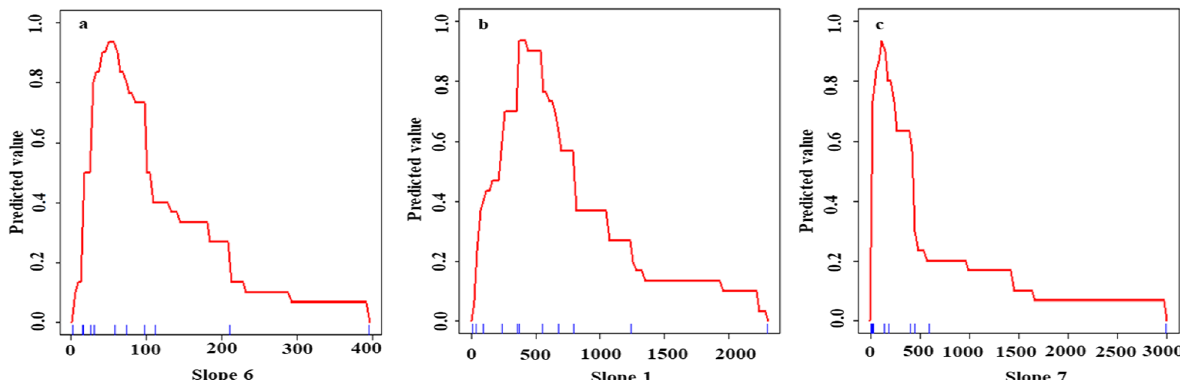
Fig. 11 Receiver operating characteristics curve (ROC) illustrating relationship between probability of occurrence of suitable conditions for distribution of C. wightii with most significant slope types slope 6 ( a ), slope 1 ( b ) and slope 7 ( b )